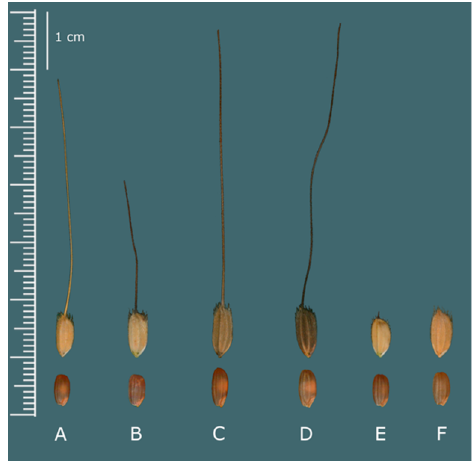
Figure 2. Examples of different Italian weedy rice populations with different hull and pericarp colors and variable presence, color and lengths of the awns. ( A ) straw-awned strawhull, ( B ) black-awned strawhull, ( C ) brown-awned brownhull, ( D ) blackawned blackhull, ( E ) mucronate strawhull, ( F ) awnless strawhull.